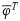
Evaluation of standard and adjusted FST estimators.The convergence values we calculated for the standard kinship plug-in and adjusted FST estimators are validated using our admixture simulation. All adjusted estimators are unbiased but are “oracle” methods, since the mean kinship (φ¯T), mean coancestry (θ¯T), or bias coefficient (sT=θ¯TFST for IAFs, replaced by φ¯TFST for genotypes) are usually unknown. (A) Estimation from individual-specific allele frequencies (IAFs): F^STstd is the standard coancestry plug-in estimator in Eq (26); F^ST′ “Adj. θ¯T” is in Eq (27); F^ST′′ “Adj. s” is in Eq (31). (B) For genotypes, F^STstd is given in Eq (25), and the adjusted estimators use φ¯T rather than θ¯T. Lines: true FST (red line), limits of biased estimators F^STstd (green lines, which differ slightly per panel). Estimates (blue) include 95% prediction intervals (too narrow to see) from 39 independently-simulated genotype matrices for our admixture model (Methods, section Prediction intervals).